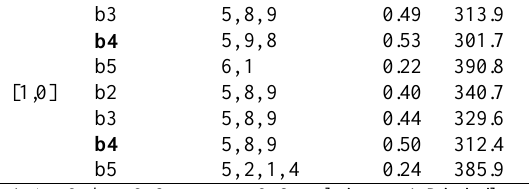
Table 1. AGBC estimates using Landsat 8 texture metrics from 3×3, 5×5, 7×7, 9×9 window sizes and offsets [0,1], [1,0],